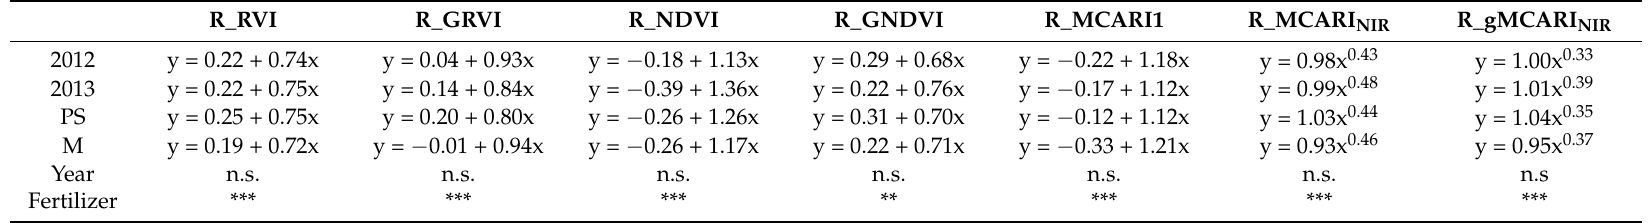
Table 3. Best models for the relationships between R_yield (y) (relativized to maximum value of each year) and R_VIs (x) (relativized to maximum value of each year) for years 2012 and 2013, for the PS and M treatments. The last two rows give the significance of the comparison between years and the type of